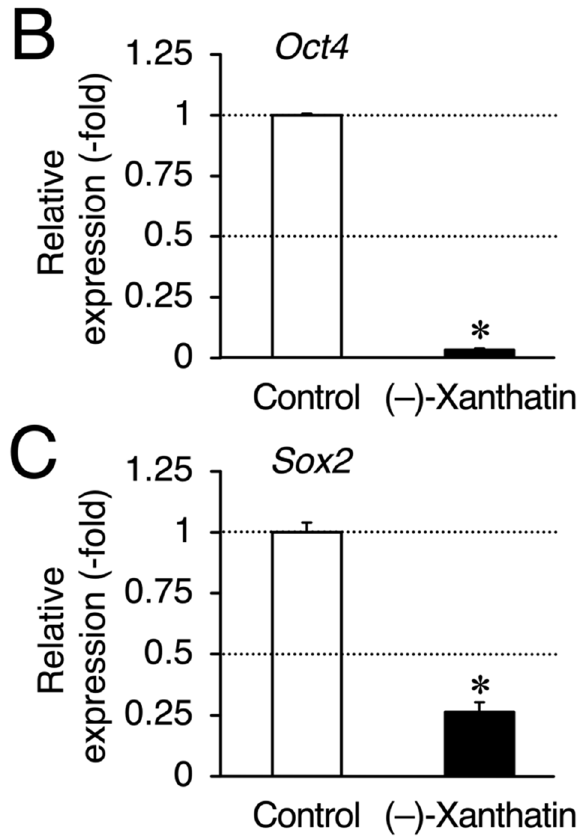
Figure 4. (–)-Xanthatin-mediated down-regulation of the expression of Nanog , Oct4 , and Sox2 in mammospheres derived from MCF-7 cells. Real-time RT-PCR analysis of Nanog ( A ), Oct4 ( B ), and Sox2 ( C ) in mammospheres after 72 h of the treatment with vehicle or 25 µM (–)-xanthatin. Data are presented as the mean ± S.E. ( n = 3) of the fold induction compared to the vehicle-treated control. * Significant differences ( p < 0.05) from the vehicle-treated control.